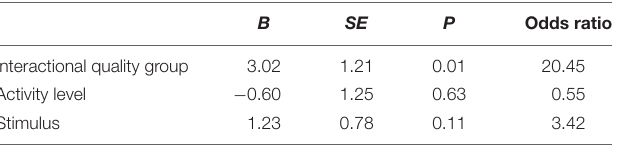
TABLE 4 | Results from logistic regression analysis of infant transfer success. B SE P Odds ratio Interactional quality